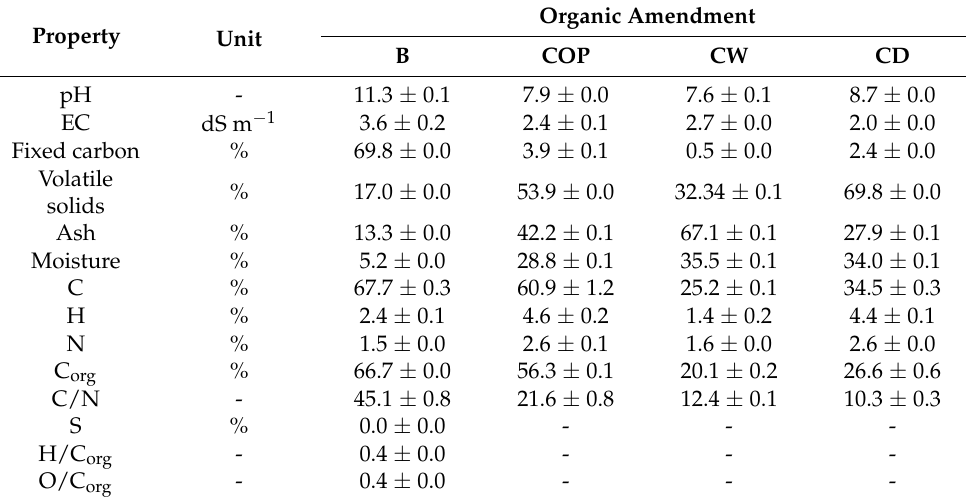
C/N - S % 0.0 ± 0.0 - H/C org - 0.4 ± 0.0 - - O/C org - 0.4 ± 0.0